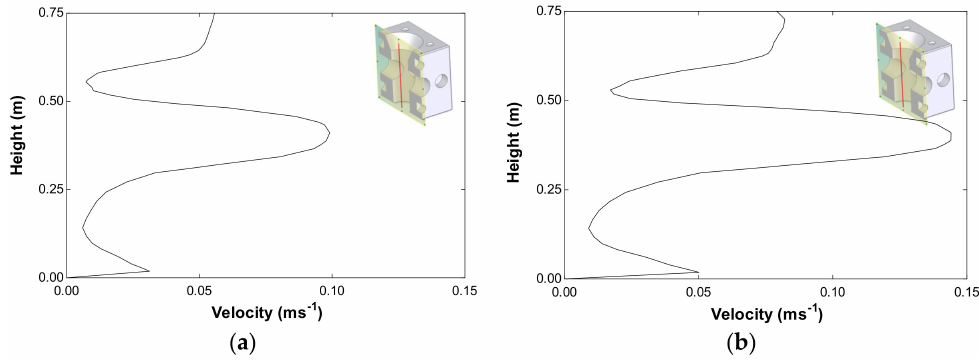
Figure 11. Velocity field in the middle of the AR. Orientation B. ( a ) 0.074 ms − 1 current velocity; ( b ) 0.110 ms − 1 current velocity.